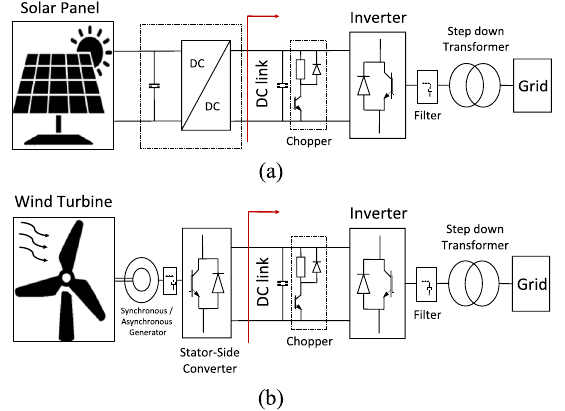
Fig. 1 Structure of IBRs: a photovoltaic plant, b wind farm type IV